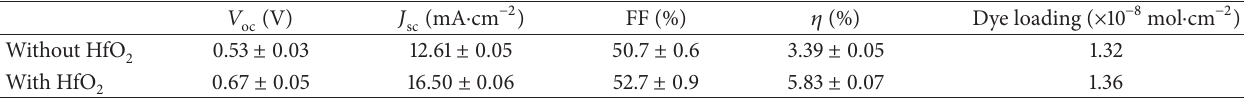
blocking layer by ALD a . 2